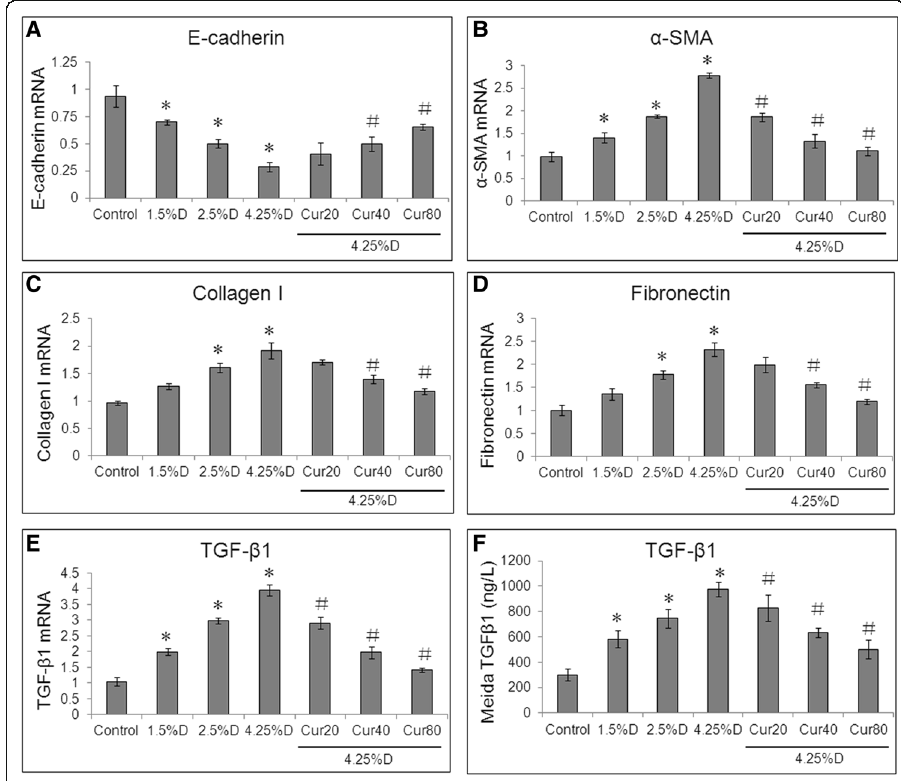
Fig. 2 Effect of curcumin on PD-induced mRNA expressions of EMT-related genes in HMrSV5 cells. Cells were divided into control group (cells treated with DMEM/F12 medium containing 0.5%FBS), three PD groups (cells treated with 1.5% Dianeal, 2.5% Dianeal and 4.25% Dianeal), and three 4.25% Dianeal + curcumin group (cells treated with 4.25% Dianeal plus curcumin of 20, 40 and 80 μ M). After incubation for 48 h, cells were lysed using TRIzol reagent for quantitative real-time PCR assay, and culture supernatant was collected for ELISA assay. GAPDH served as a loading control. Relative mRNA expressions of E-cadherin ( a ), α ⁃ SMA ( b ), collagen I ( c ), fibronectin ( d ) and TGF ⁃ β 1 ( e ) are shown. TGF- β 1 protein content in culture supernatant was determined ( f ). * P < 0.05 vs. control group; # P < 0.05 vs. 4.25% Dianeal